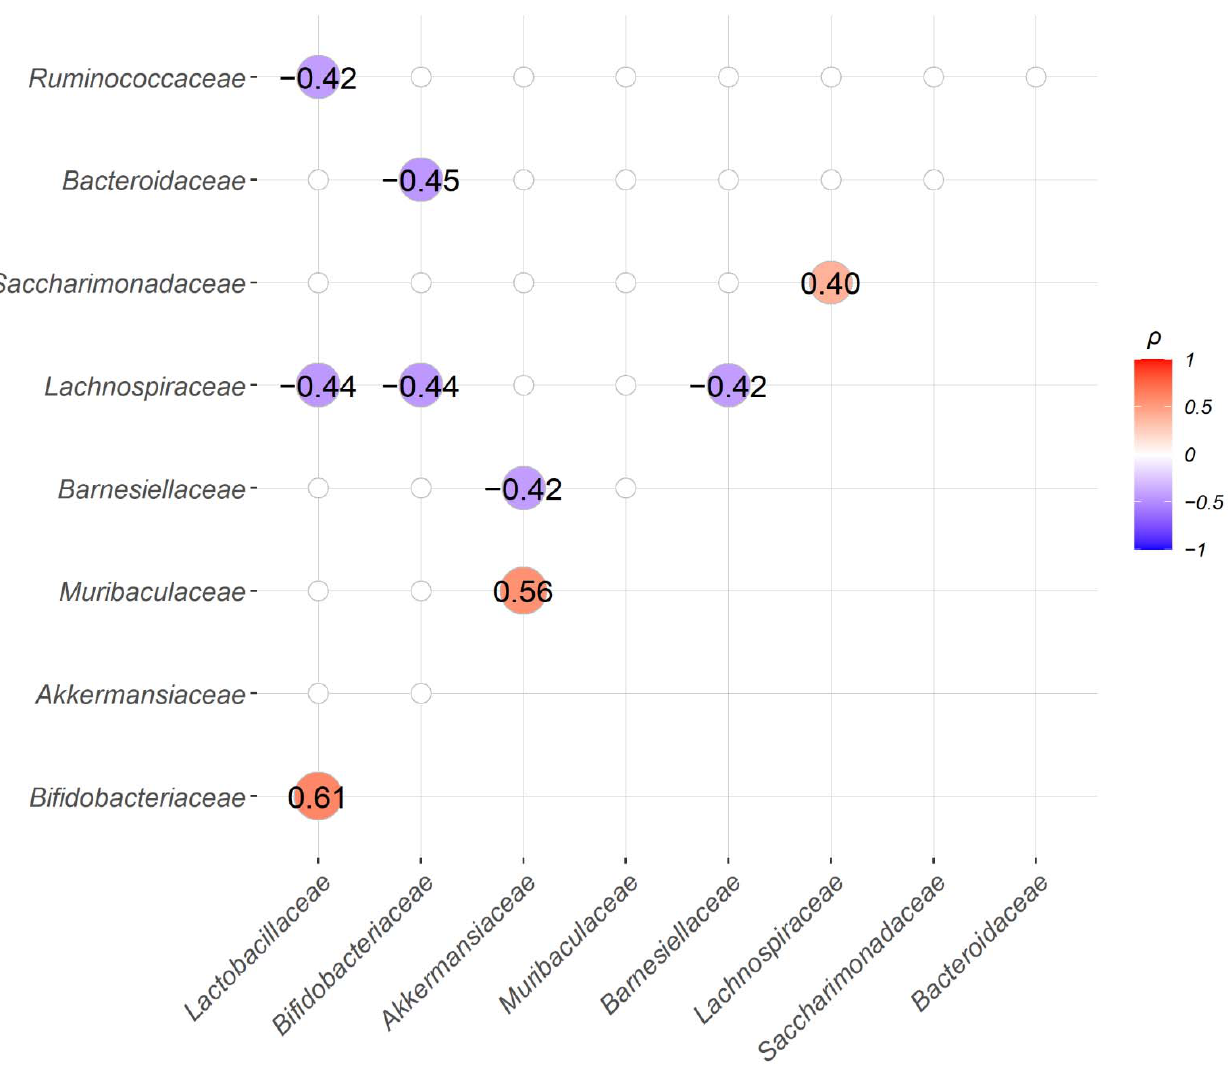
Figure 7. Correlation analysis between the abundance of the top 10 bacteria families, except for the “unassigned” group, showed three significant positive and six significant negative bacteria family pairs. Spearman’s correlation coefficients ( ρ ) for the abundance of paired bacteria families were calculated from all 30 samples and only family pairs with significant correlations are shown (BH adjusted p -value < 0.05).